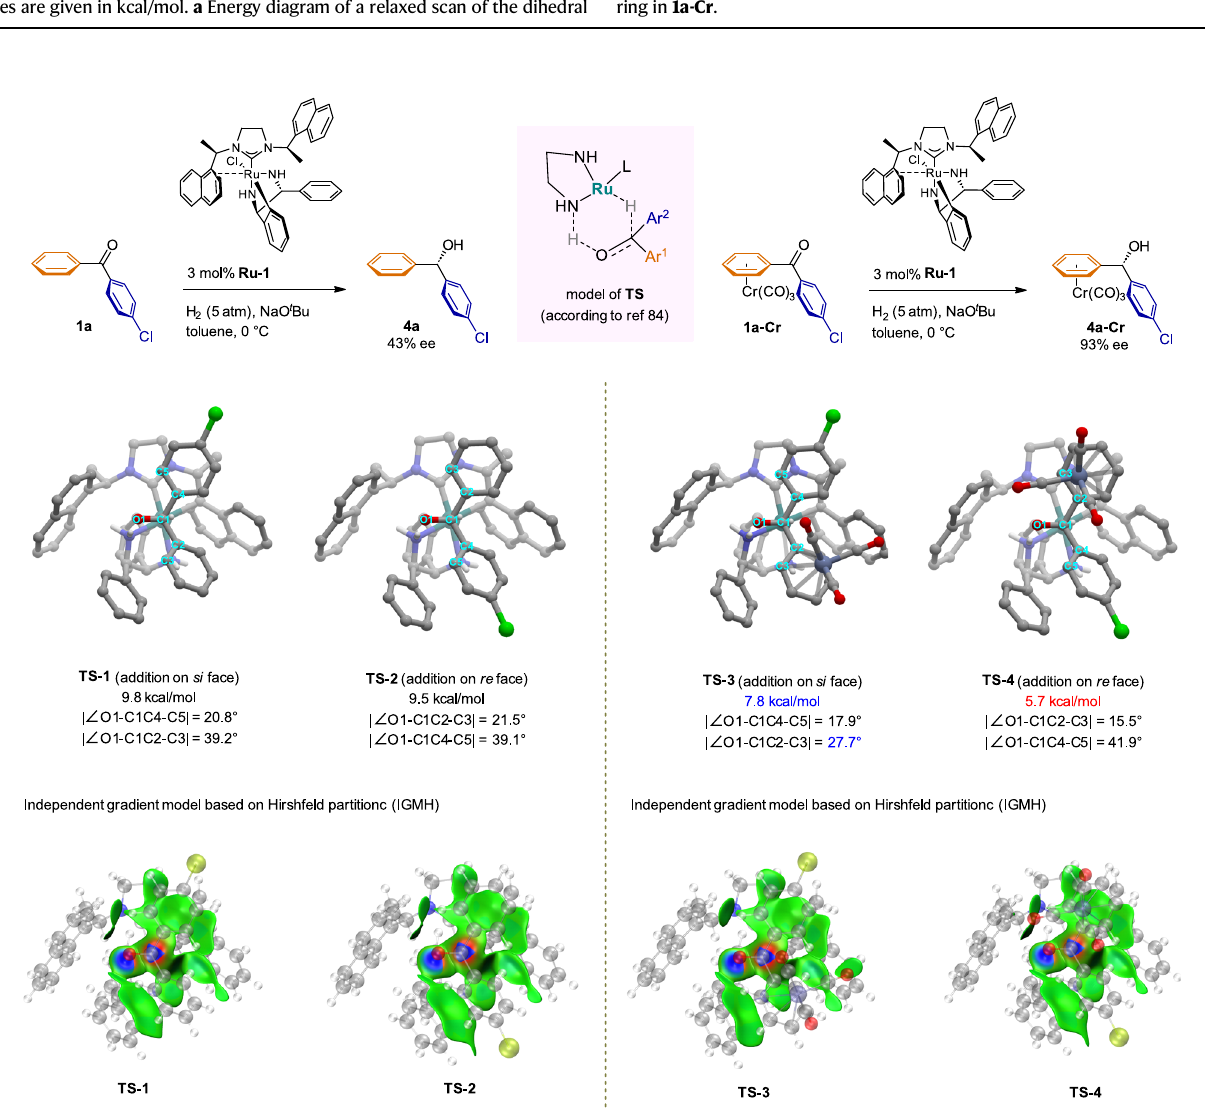
Fig. 8 | Computational studies of transition states for asymmetric hydro- genation of 1a and 1a-Cr. The relative Gibbs free energies are given in kcal/mol. Left part, computationalstudiesof transitionstatesforasymmetrichydrogenation